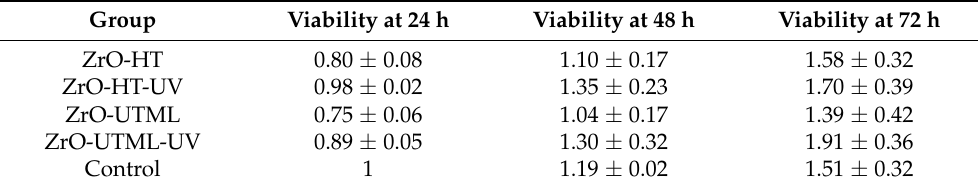
Table 4. Fibroblast proliferation results are presented as mean and SD values for the three Table 3. Water contact angle in degrees for the four groups is presented as means ± standard devi- investigated ations.